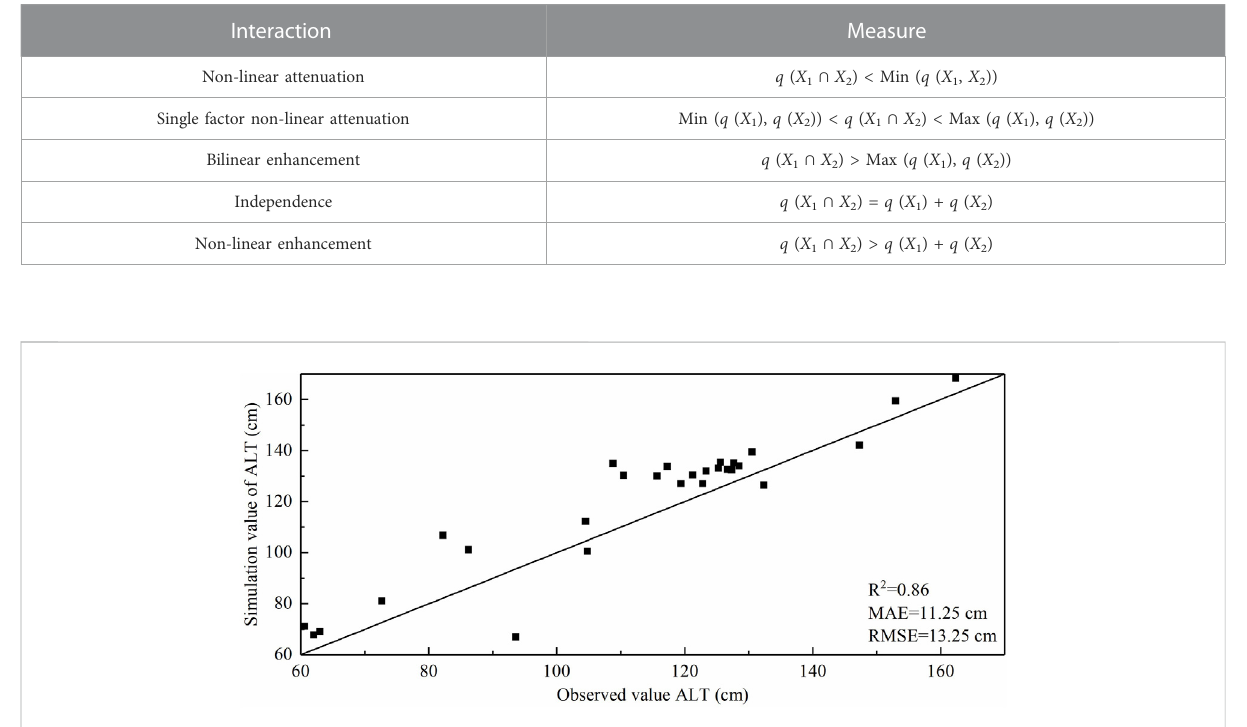
FIGURE 3 Simulated and measured values 1:1 histogram (black solid line is y= x ).